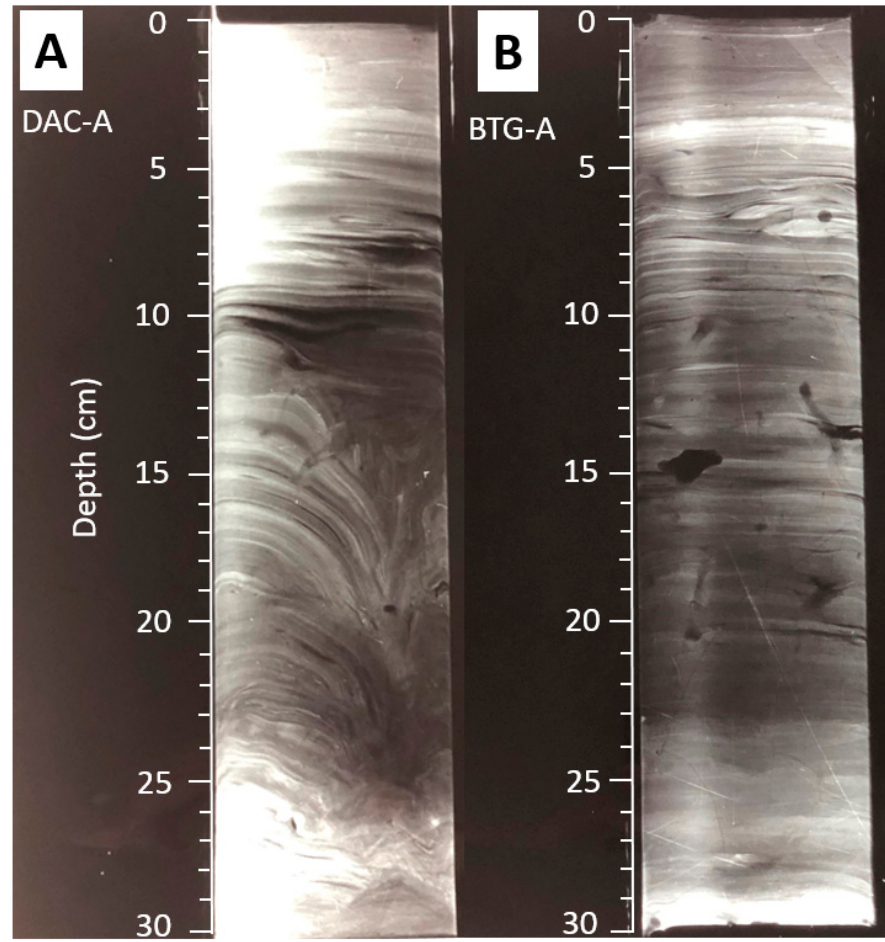
Figure 6. X-radiograph negatives collected from box cores at ( A ) DAC-A and ( B ) BTG-A locations illustrating evidence of tidal and seasonal depositional influences (see Figure 5 for core locations and position within the stratigraphy). Darker colors represent less dense sediments (e.g., fine silts), while light colors correspond to sediments with relatively high density (e.g., coarse silts and sands). Extensive deformation of bedding below 10 cm depth at DAC-A was likely produced by human activity (footprint). Table 1. Median grain size proportions for auger core locations and depositional zones. Note that changes in sand (and mud) content are particularly pronounced between BTG and KAL (across the backwater), as well as between MHP and KMK (near the limit of tidal influence). Mean tide ranges, originally reported by EGIS (2000) and BIWTA (2019), take into account neap/spring variation and seasonal conditions. Water salinity values for the dry season were reported by Winterwerp and Giardino (2012); water salinity is negligible for all sites during the monsoon season.